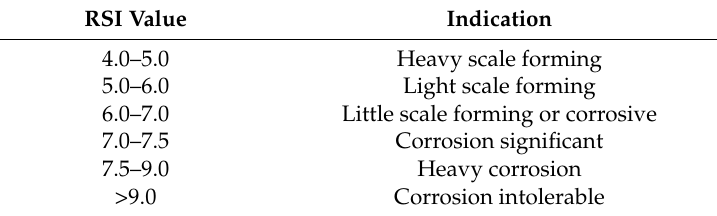
Table 2. Interpretation of the Ryznar Stability Index (RSI)